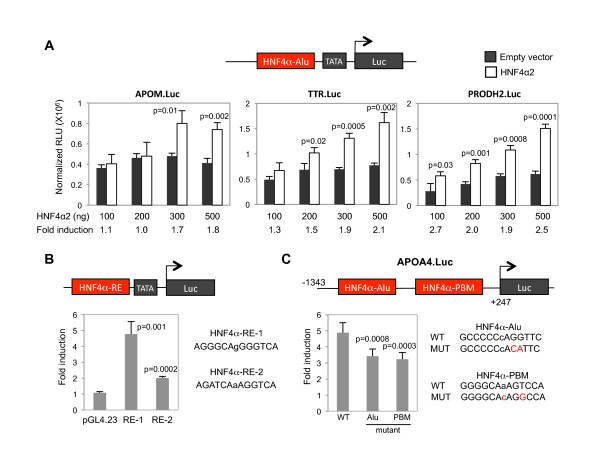
HNF4α activates transcription from Alu elements. A. Reporter gene assay with the HNF4α-Alu elements from the indicated human gene promoters fused to a minimal core promoter driving luciferase (pGL4.23). Shown is luciferase activity (relative light units, RLU) normalized to β-gal activity (normalized RLU) from HEK 293T cells transiently transfected with 1 μg of reporter and different amounts of either empty vector or human HNF4α2 expression vector (100, 200, 300 and 500 ng). Reporter constructs contain only the HNF4α-Alu element and immediately adjacent sequence; they do not contain any additional known HNF4α binding sites. Data are the mean normalized RLU of triplicate samples from one representative experiment from two or more that were performed. P-values of the HNF4α2 signal compared to the empty vector are indicated. Fold induction by HNF4α2 compared to the empty vector is indicated. B. As in (A) but with two different reporter constructs containing classical HNF4α response elements (RE-1 and RE-2). Shown is fold induction by 500 ng HNF4α2 compared to the parent construct (pGL4.23). C. As in (A) but of the native human APOA4 promoter (-1343 to +247) fused to luciferase (pGL4.10) without (WT) or with mutations (MUT) in either the HNF4α-Alu element (Alu) or a classical HNF4α site identified by a previous PBM analysis (HNF4α-PBM) (see Figure 3). Shown is the fold induction by 500 ng HNF4α2 compared to the empty expression vector from one experiment performed in six replicates. A second independent experiment performed in triplicate gave similar results. (B) and (C), sequence of the relevant HNF4α binding sites are given with the spacer nucleotide in lower case and mutations in red.